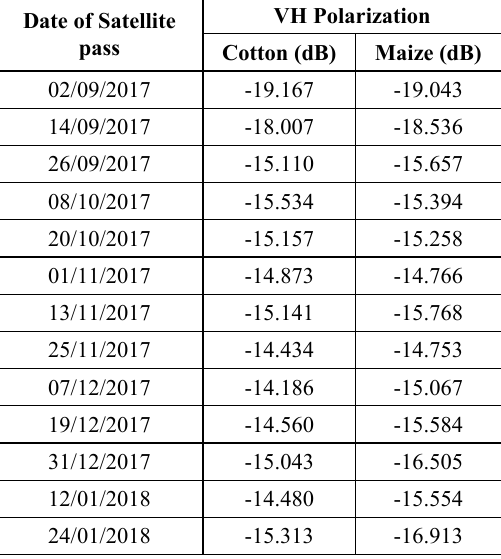
Table-2: Temporal backscatter signature for maize